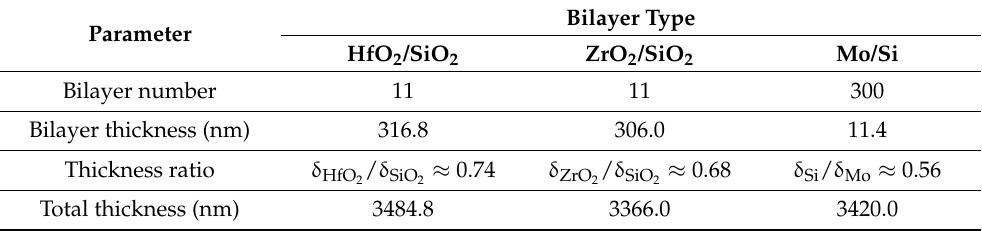
Table 1. Specifications for prepared